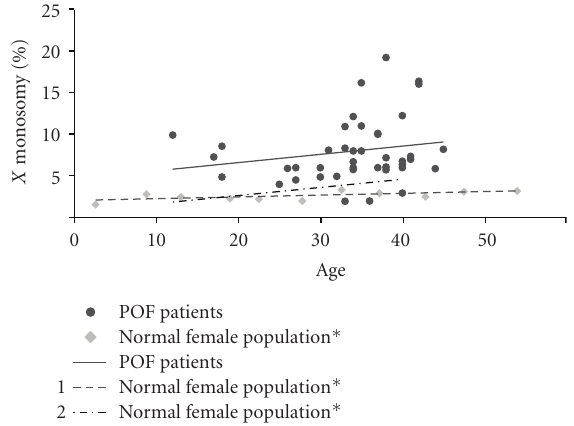
Figure 3: Percentage of X monosomy related to aging. The graph shows the linear trend of X monosomy both in POF patient group and in two di ff erent reference groups described in two reports from the literature: ∗ (1) Guttenbach et al. (1995) [10] and (2) Lakhal et al. (2010)